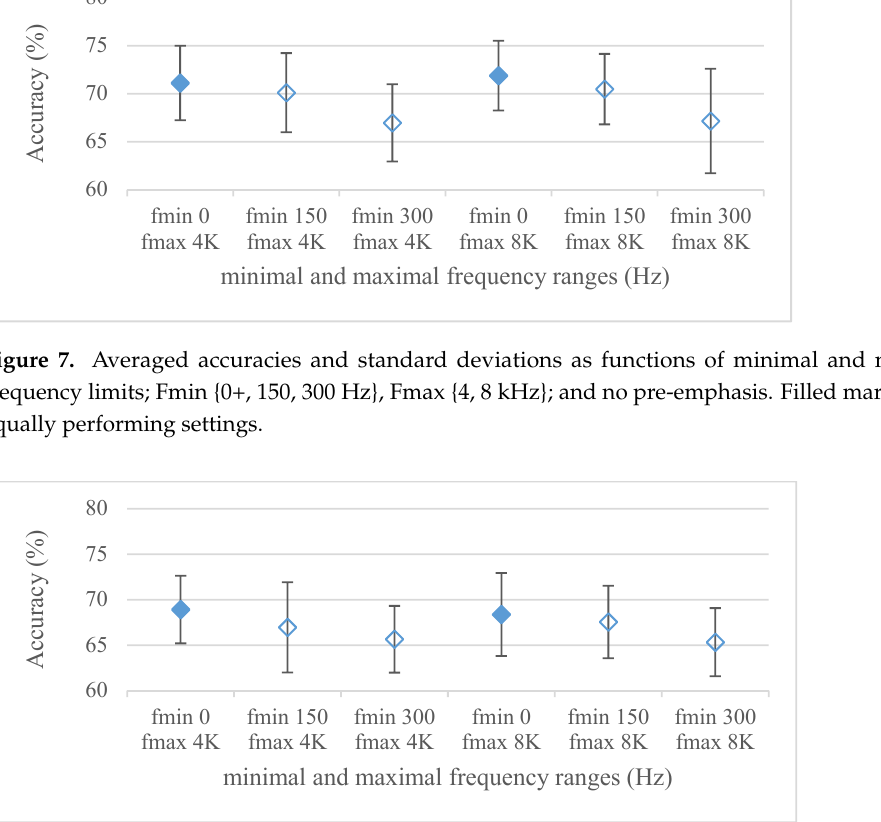
Figure 8. Averaged accuracies and standard deviations as functions of minimal and maximal frequency limits; Fmin {0+, 150, 300 Hz}, Fmax {4, 8 kHz}, and with pre-emphasis. Filled marks show equally performing settings.